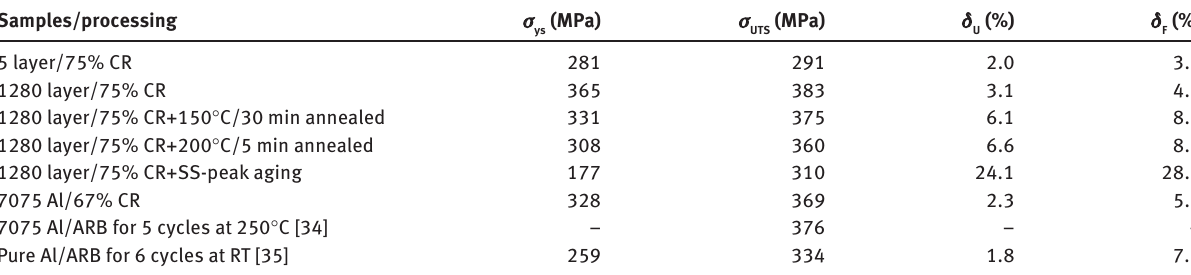
Table 2 Tensile properties of samples in this study and the comparison with that of constituent materials in references published